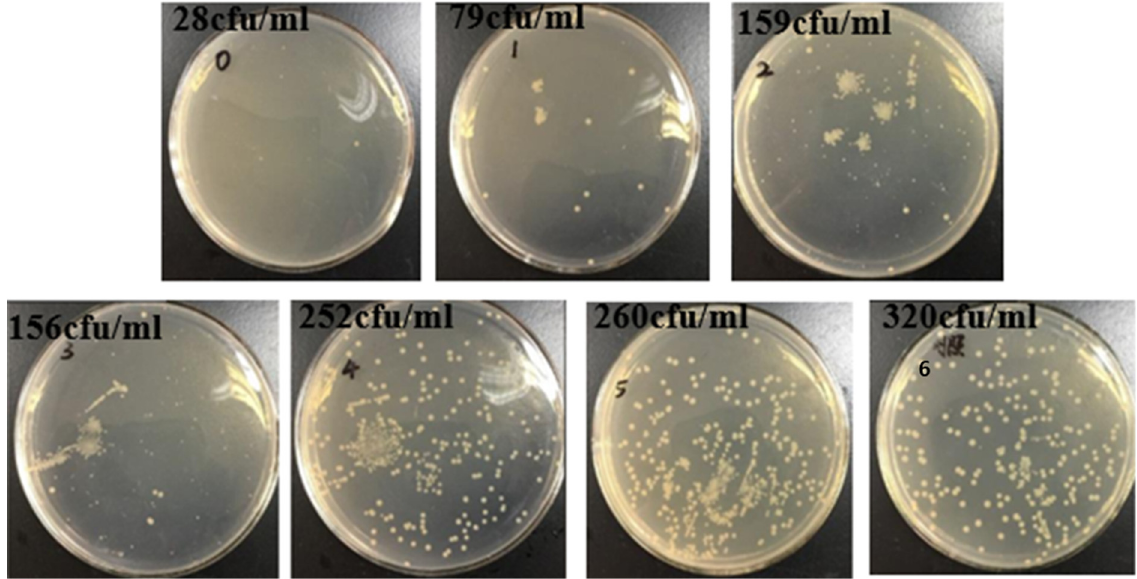
Figure 8. Survival of E. coli after 15 min of UV irradiation (0: uncoated, 1: FSM-0, 2: FSM-1.25, 3: FSM-2.5, 4: FSM-3.75, 5: FSM-5, 6: non-UV irradiation group ).